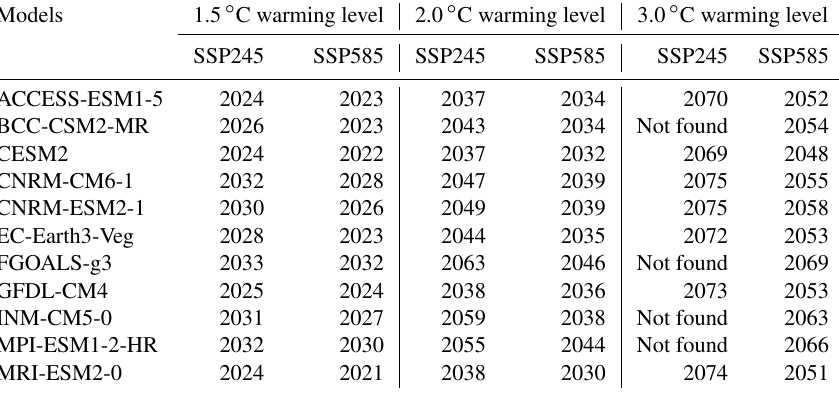
Table 2. Determination of “crossing years” for the periods reaching 1.5, 2 and 3 ◦ C warming levels for different GCM and SSP combinations.